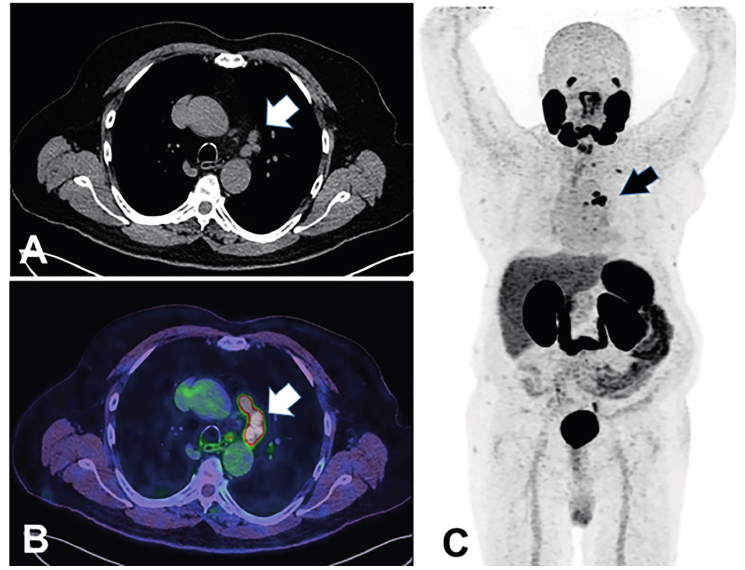
Figure 1 - Mediastinal lymph nodes metastases.